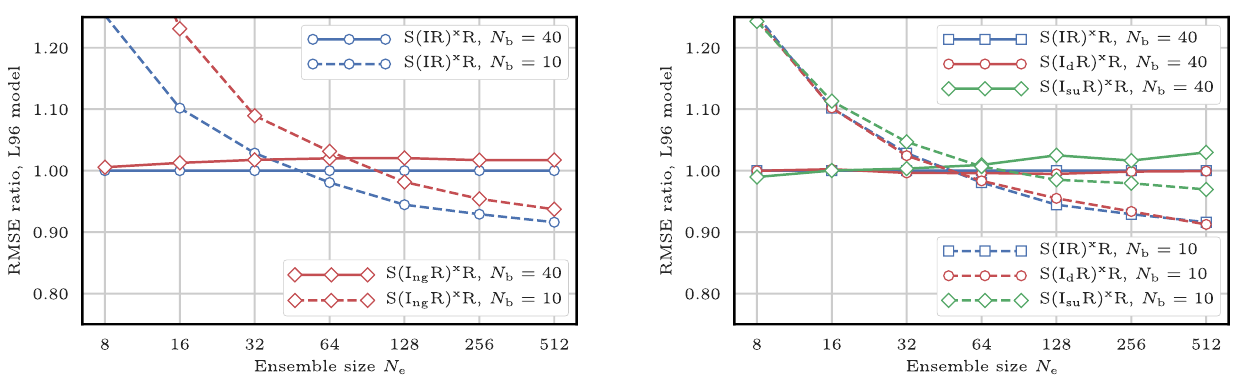
Figure 10. RMSE as a function of the ensemble size N e for the S(IR) x R, the S(IR d ) x R, and the S(IR su ) x R algorithms, with N b = 40 and 10 blocks of size 1 and 4 grid points, respectively. The scores are displayed in units of the RMSE of the S(IR) x R algorithm with N b = 40 blocks of size 1 grid